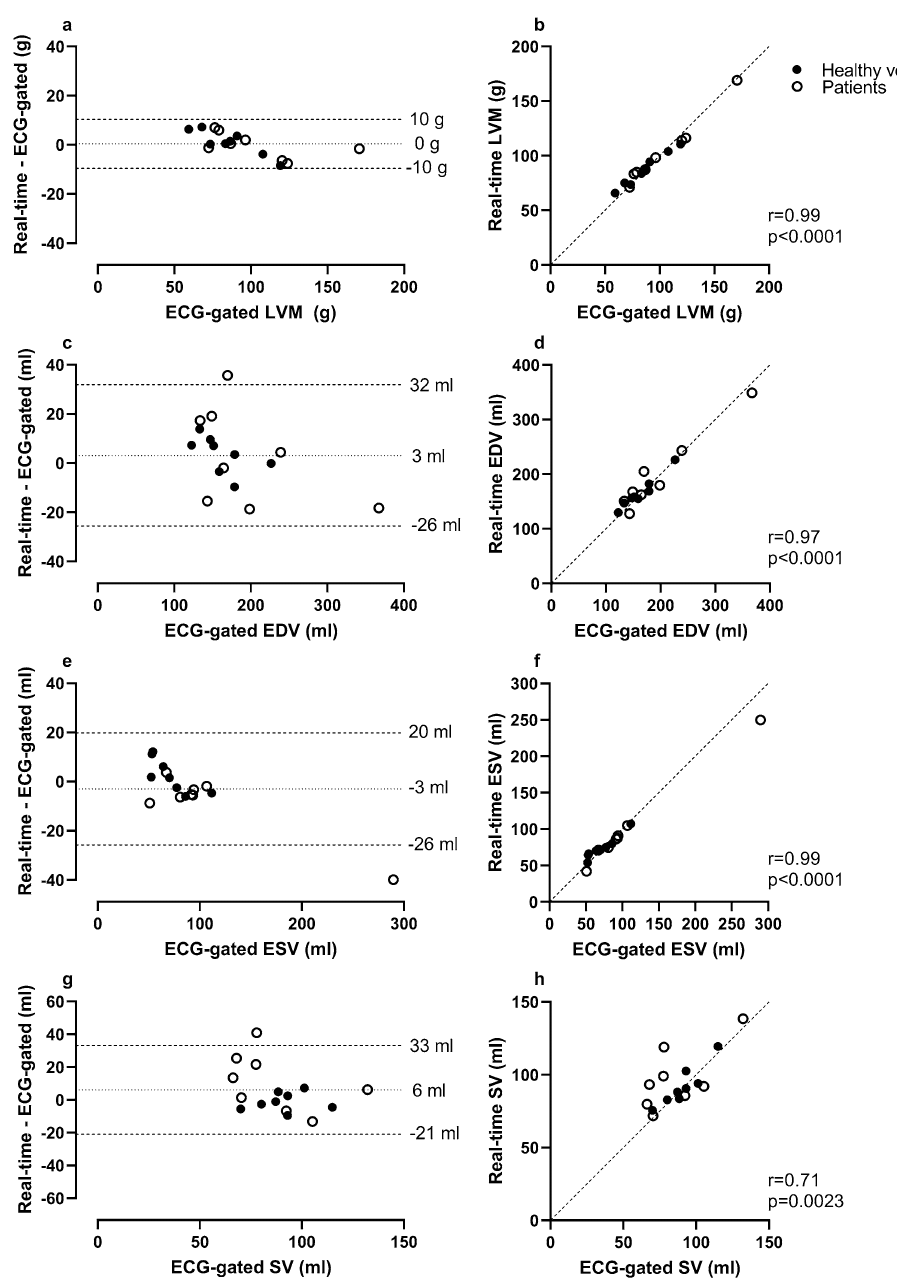
Figure 4. Agreement of left ventricular volumes, mass, and ejection fraction in real-time (RT) images at rest versus ECG-gated images at rest in eight healthy volunteers and eight patients. In all panels, RT measurements were made in stacks with a ~ 17 s image acquisition time per slice (500 time-frames). Bias was low and correlation high for all measurements. In the panels depicting EDV (c), SV (g) and EF (i), one point of measurement from the same patient can be seen outside the limits of agreement. In this case the ECG- gated images contained respiratory artifacts in several basal slices which may have impacted measurements. In the panel depicting ESV (e), one point of measurement from another patient can be seen outside the limits of agreement. In this case the patient had a severely dilated ventricle, making the absolute difference in measurements noticeable while the relative difference was comparable to other ESV measurements. In the Bland–Altman plots the dotted line represents bias, defined as the mean difference between real-time and ECG- gated measurements and the dashed lines represent the upper and lower 95% limits of agreement (bias ± 1.96 SD of the difference). In the scatter plots the dashed line represents a line of identity. LVM = left ventricular mass; EDV = end diastolic volume; ESV = end systolic volume; SV = stroke volume; EF = ejection fraction